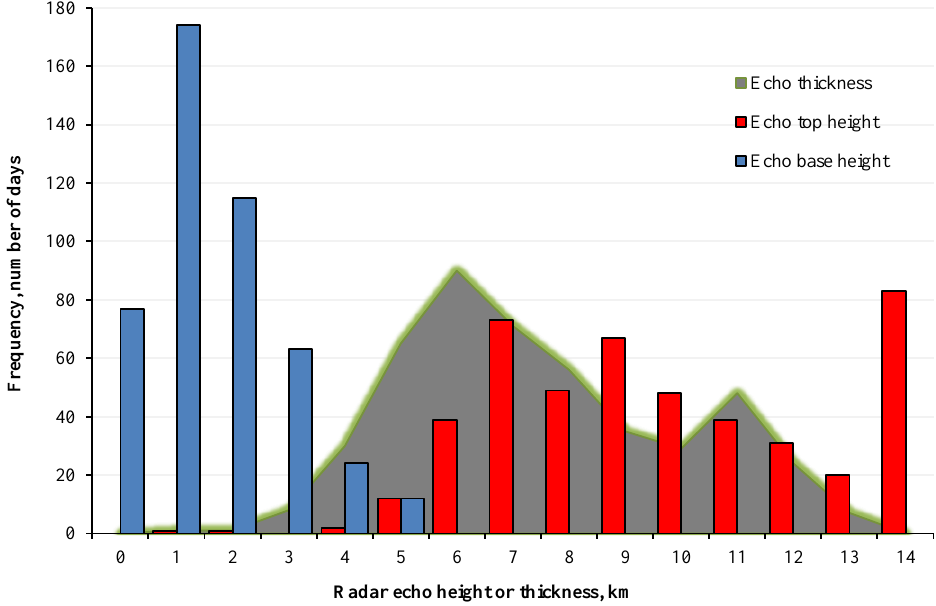
Fig. 3. The frequency distribution of weather radar Echo height EHT product parameters on days with more than 10 lightning flashes detected in Latvia over the period